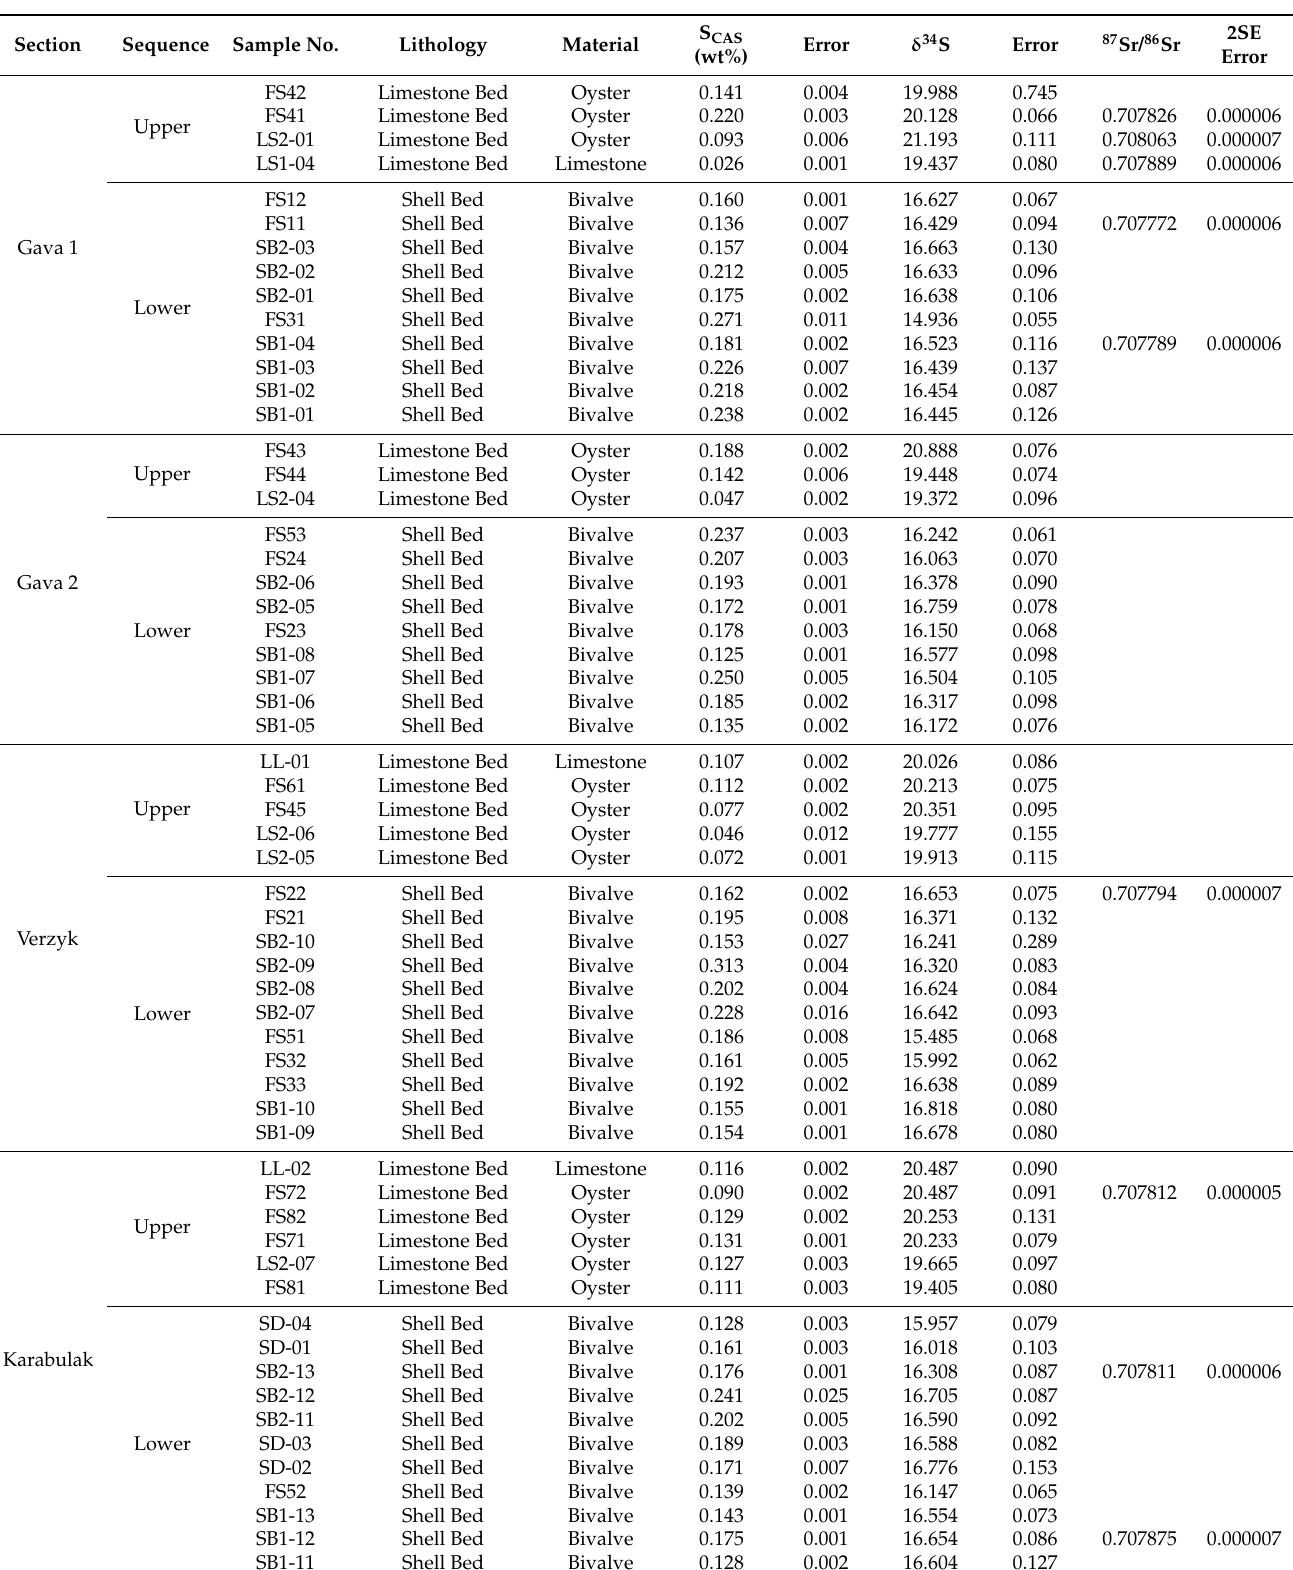
Table 1. Details of the samples employed for sulfur and strontium analyses and the corresponding